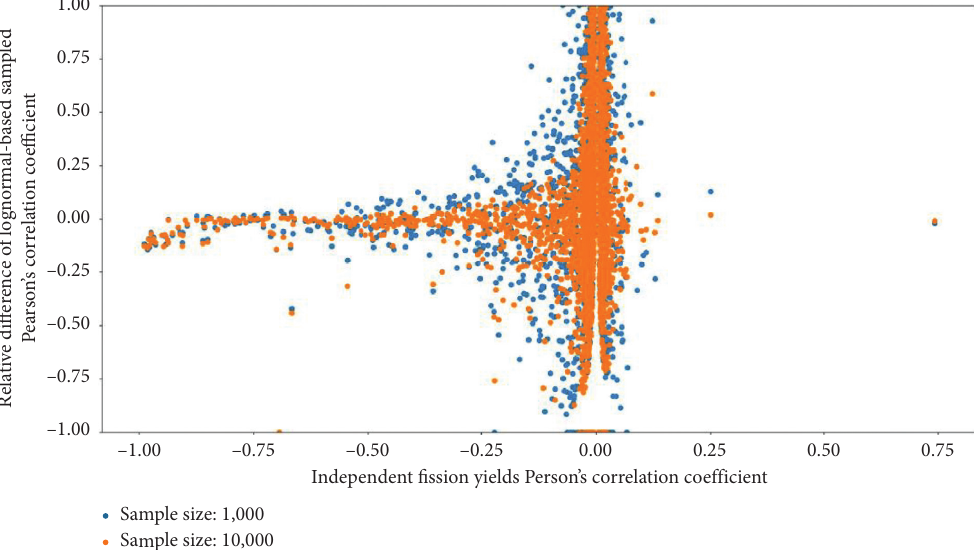
Figure 13: Relative difference of lognormal-based sampled independent fission yields Pearson’s correlation coefficients to Bayesian updated values against Bayesian updated correlation coefficients. Blue dots represent the values obtained from 1,000 samples and orange dots represent the values obtained from 10,000 samples. Table 5: Independent yield physical constraints consistency.